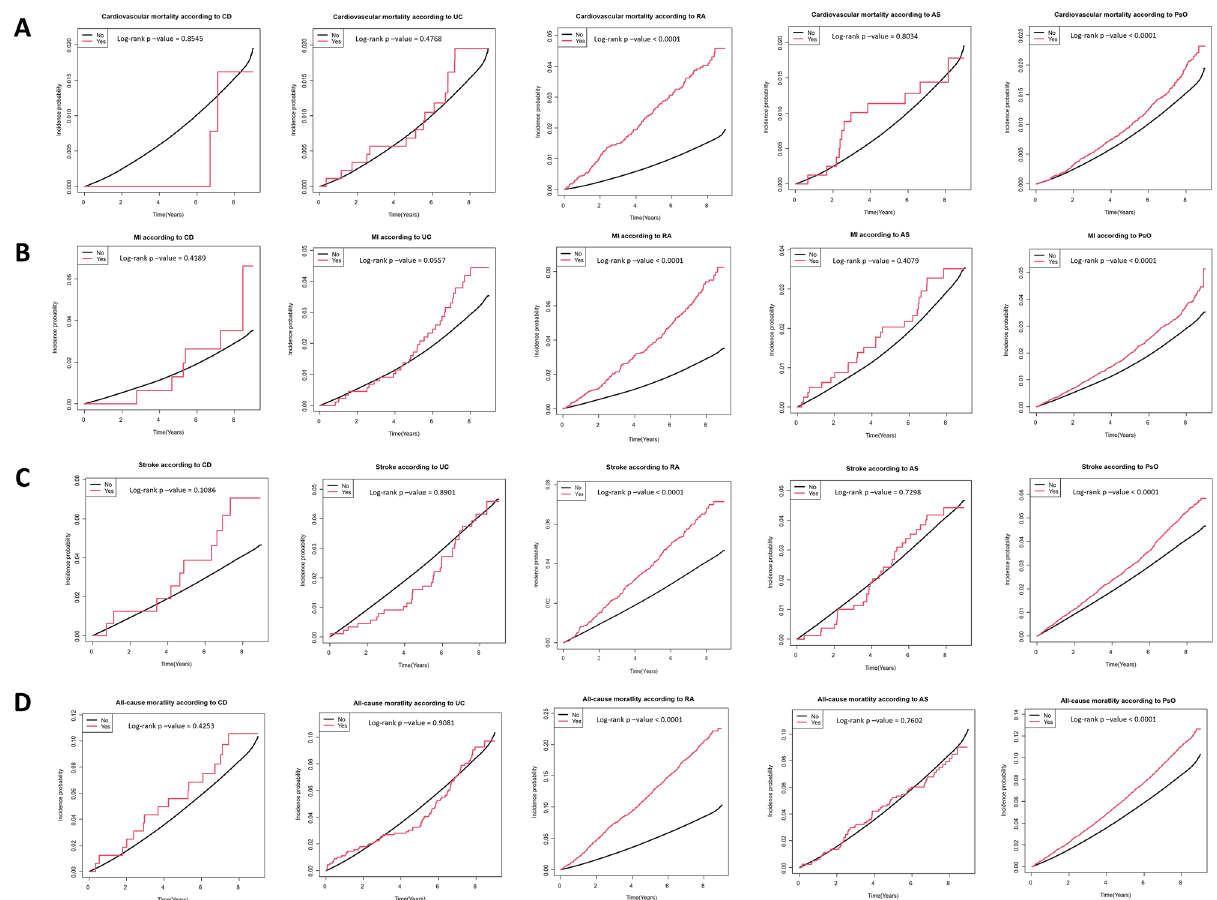
Figure 2. Comparison of cumulative incidence of ( A ) cardiovascular mortality, ( B ) MI, ( C ), stroke, and ( D ) all-cause mortality according to the presence of each IMID. CD, crohn’s disease; UC, ulcerative colitis; RA, rheumatoid arthritis; AS, ankylosing spondylitis; PsO, psoriasis; MI, myocardial infarction; IMIDs, immune- mediated inflammatory